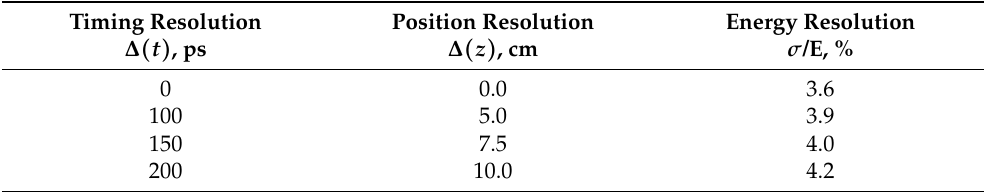
Figure 9. Schematic view of a Cherenkov fiber calorimeter using timing for the longitudinal segmentation. Table 1. The energy resolution of the 3D GNN reconstruction with various timing resolutions for longitudinal